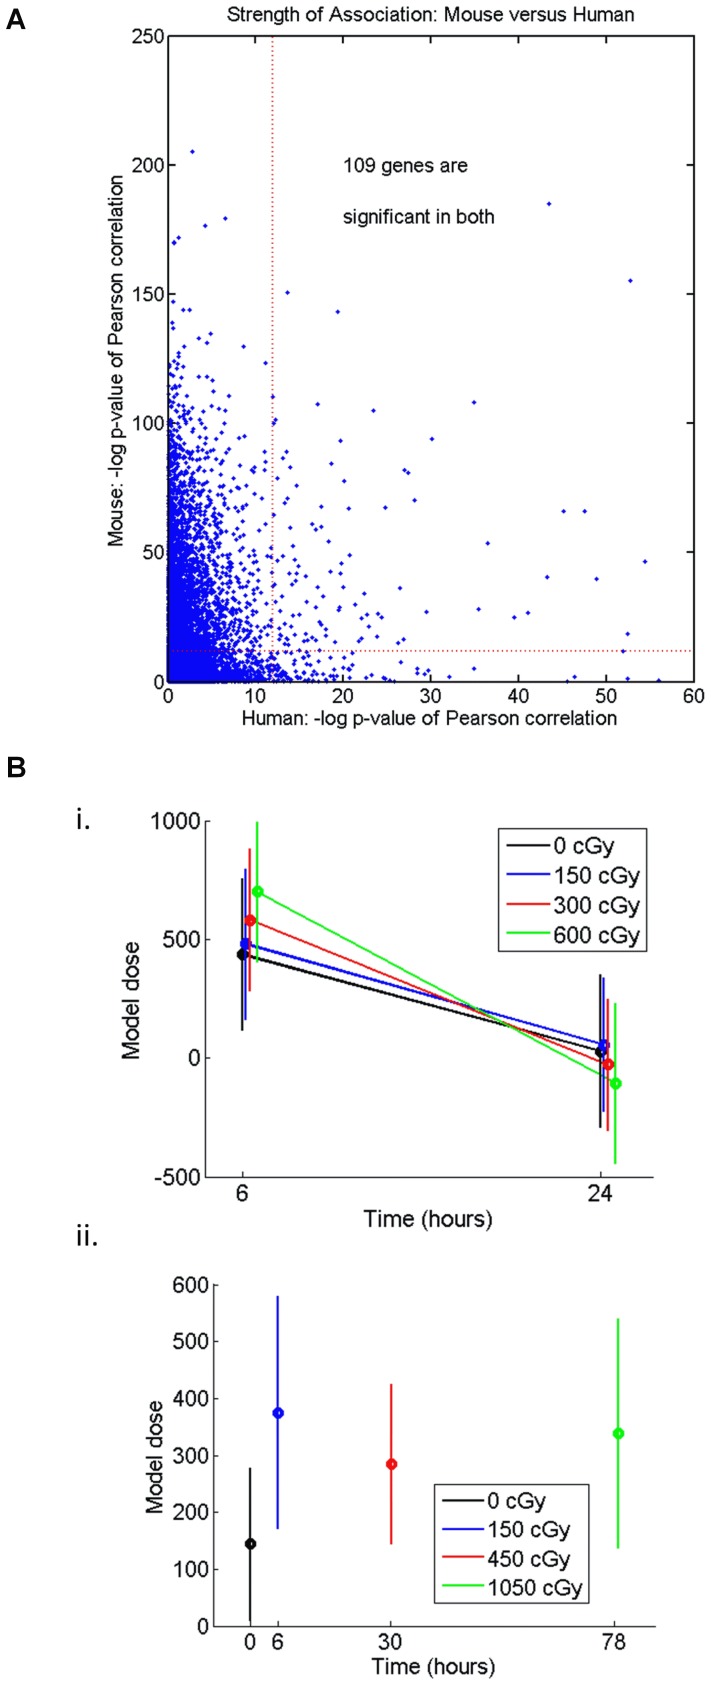
Murine gene expression profiles do not predict human radiation status.A) A Minority of Murine Radiation Response Genes Are Expressed in Humans. The scatterplot shows –log (P-value) for a Pearson test of correlation between radiation exposure dose and gene expression for each gene with a mouse-human analog. If mouse (y-axis) and human (x-axis) were identifying the same genes, then we would expect that the points would fall on a diagonal line. Approximately 9,000 mouse genes have clear human analogues on the U133A microarray. 3,353 genes have significant association with dose (p-value <.05 after correction for multiple testing). Of those, 109 genes are significantly associated in humans. B) Performance of the Murine Radiation Classifier Against Human PB Samples. We used penalized regression with individual genes as potential independent variables to build a model predicting radiation exposure dose in mice. However, using variable selection to build models that predict radiation in mice does not lead to models that predict radiation exposure in humans. Panel i shows the mean predicted radiation levels (+/− SEM) of human ex vivo irradiated blood samples at 6 hrs and 24 hrs. Panel ii shows the mean predicted radiation levels of human TBI patient samples. The x-axis shows the times after irradiation at which gene expression measurements were taken. Actual radiation doses are displayed by different colors. Note the overlap between predicted mean radiation values in each analysis.